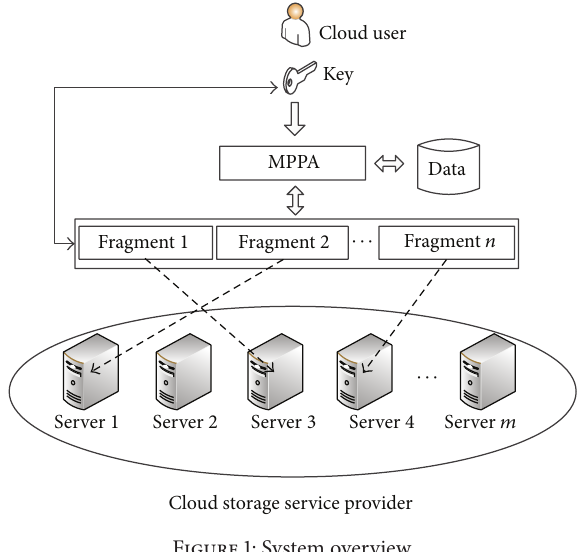
Figure 1: System